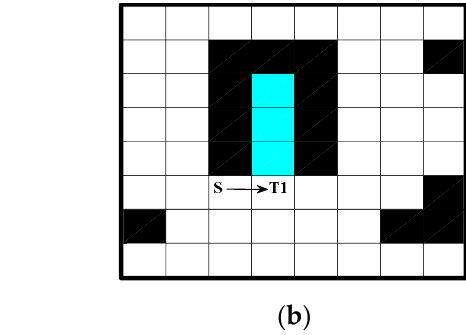
( c ) Figure 5. Schematic diagram of path smoothing optimisation; ( a ) Editable node determi- nation; ( b ) The path of mobile robot ; and ( c ) The path of mobile obstacle. 1.